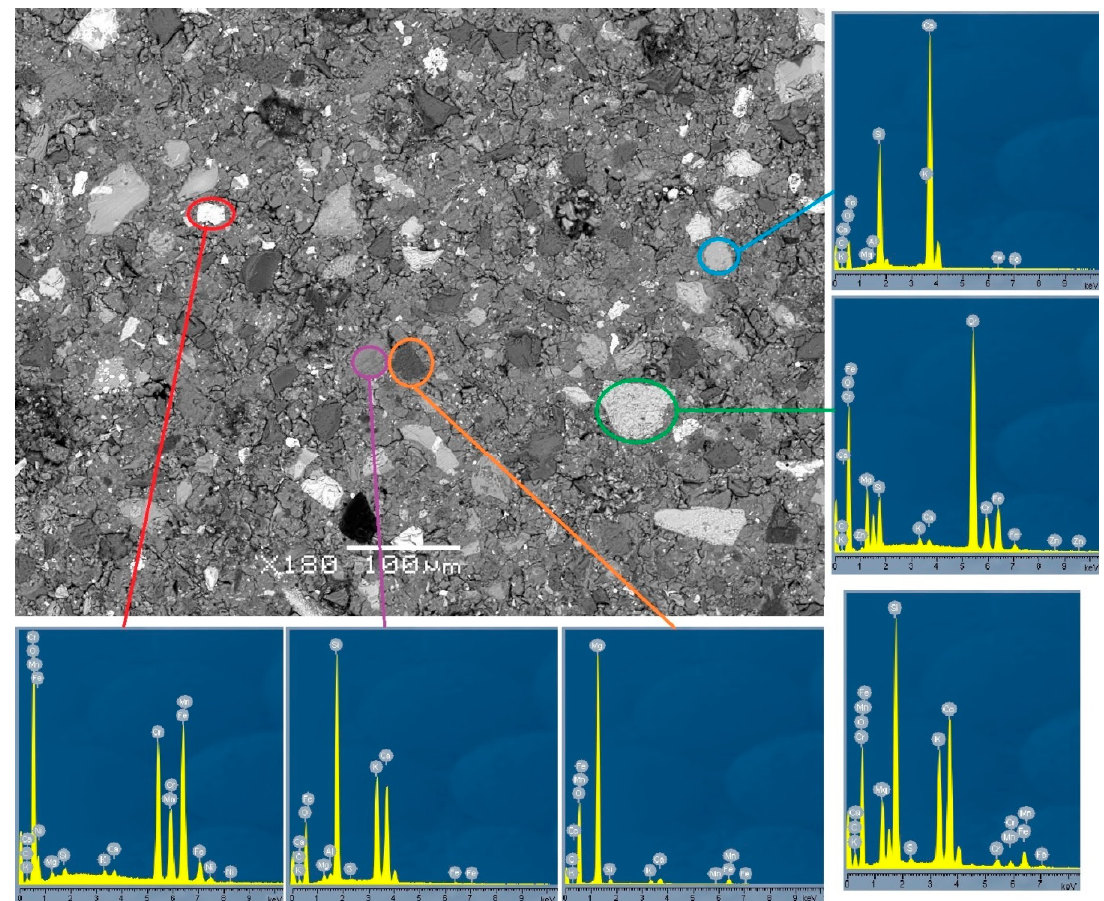
Figure 12. EDX analysis of A/R: 1/1 sample cured at 70 °C for 1 day. The unmarked EDX shows overall analysis of the AAM, purple is matrix, the rest present unreacted particles from slags.